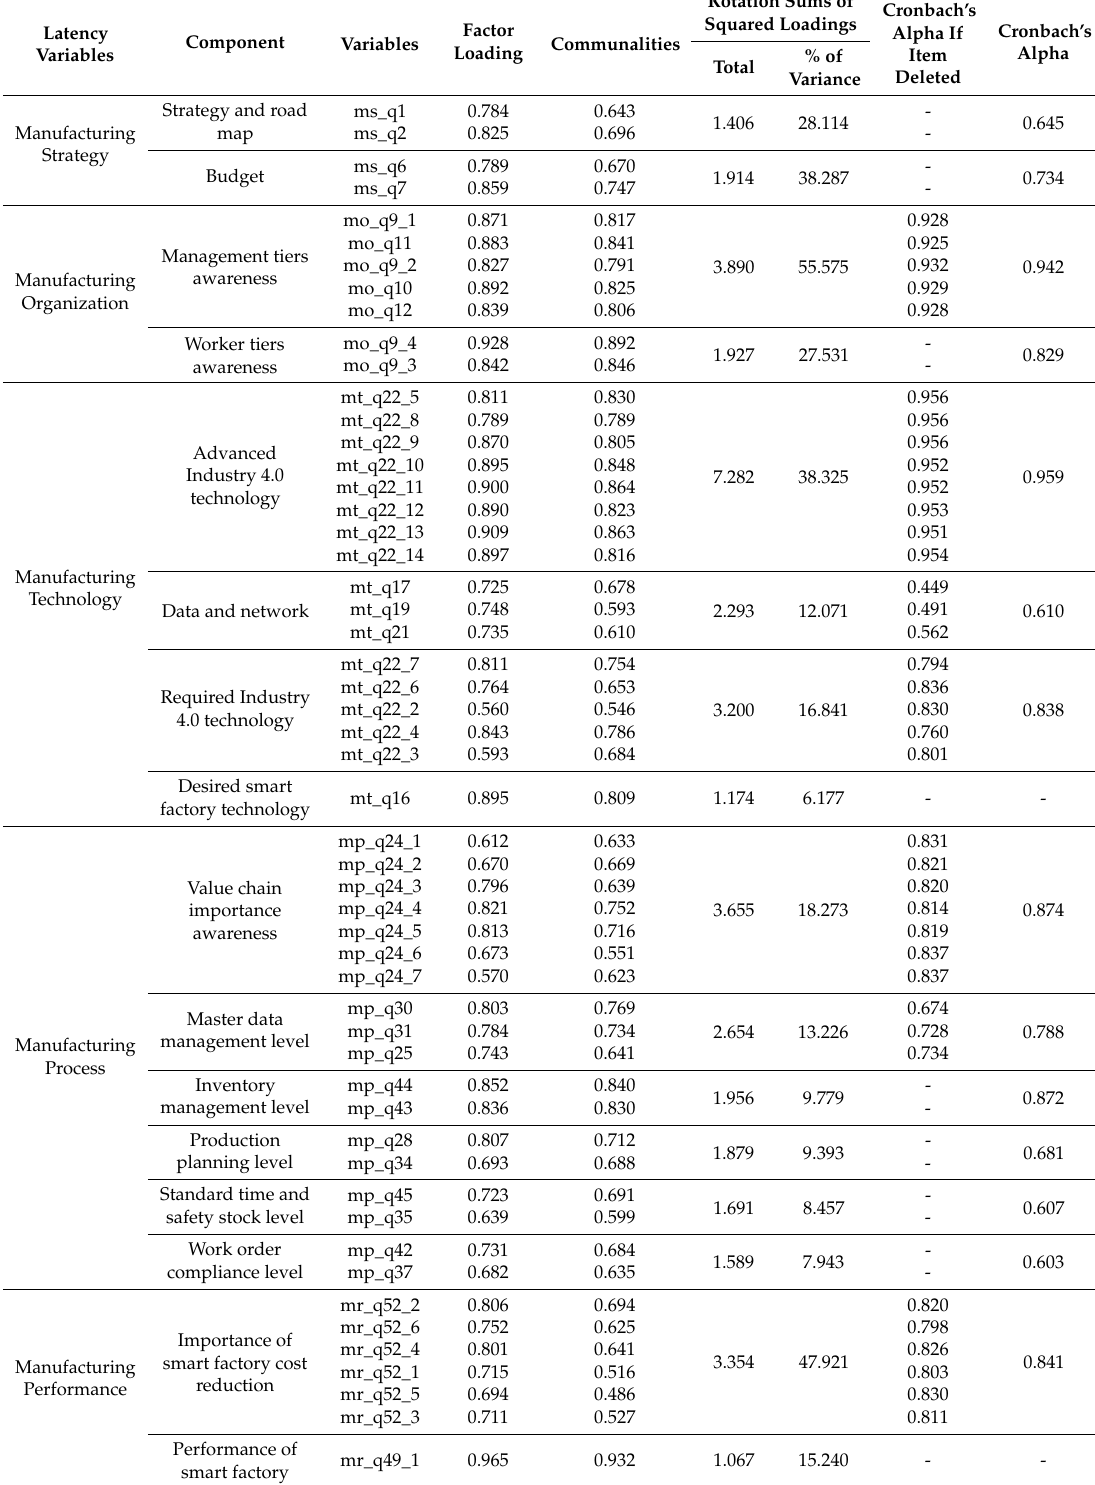
Table 8. Results of reliability